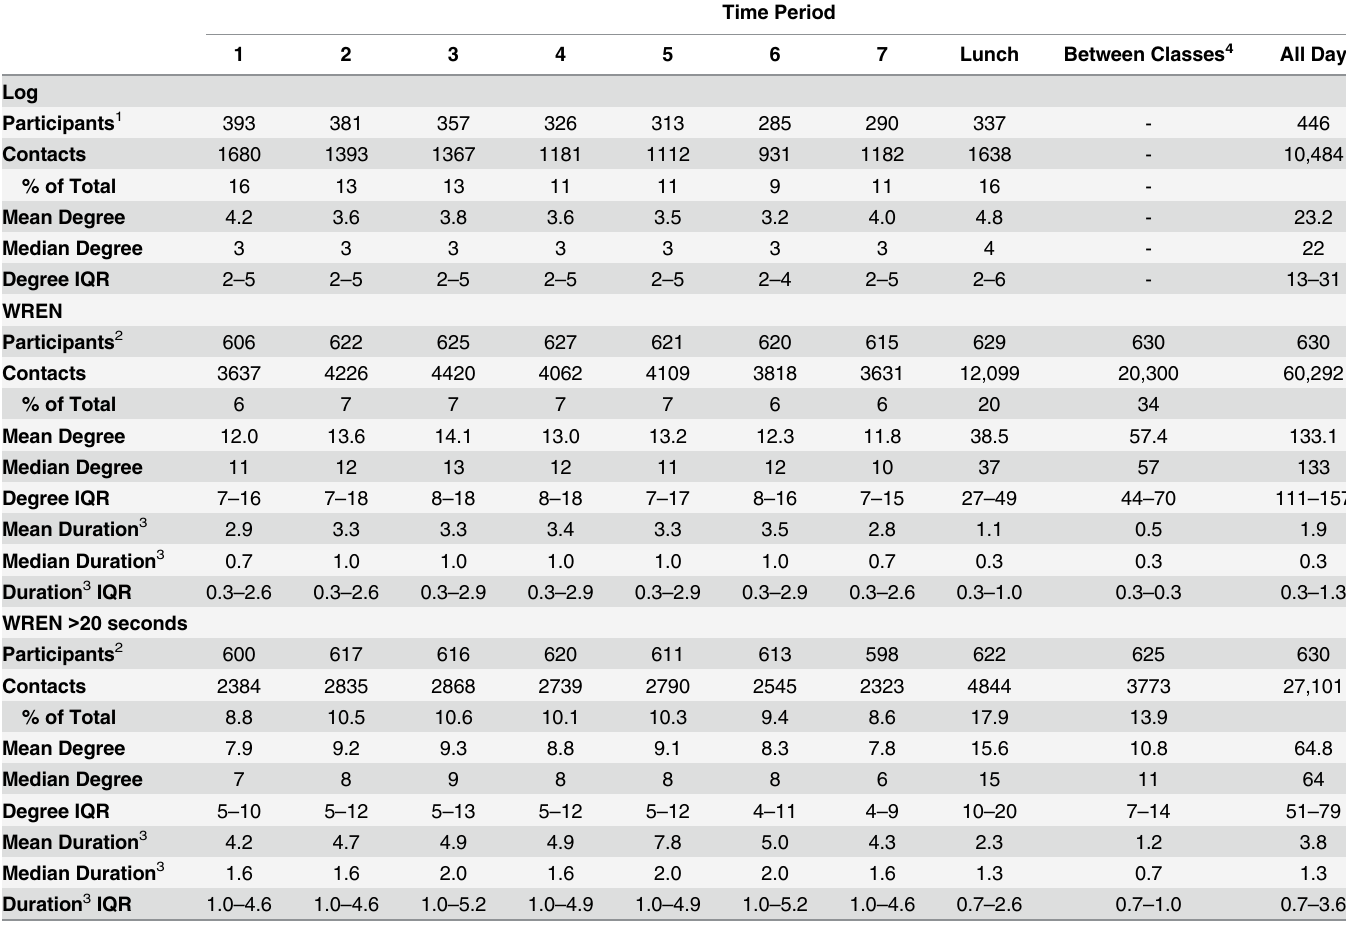
Table 3. Summary of captured contact pairs from Log and WREN during each period of the school day and